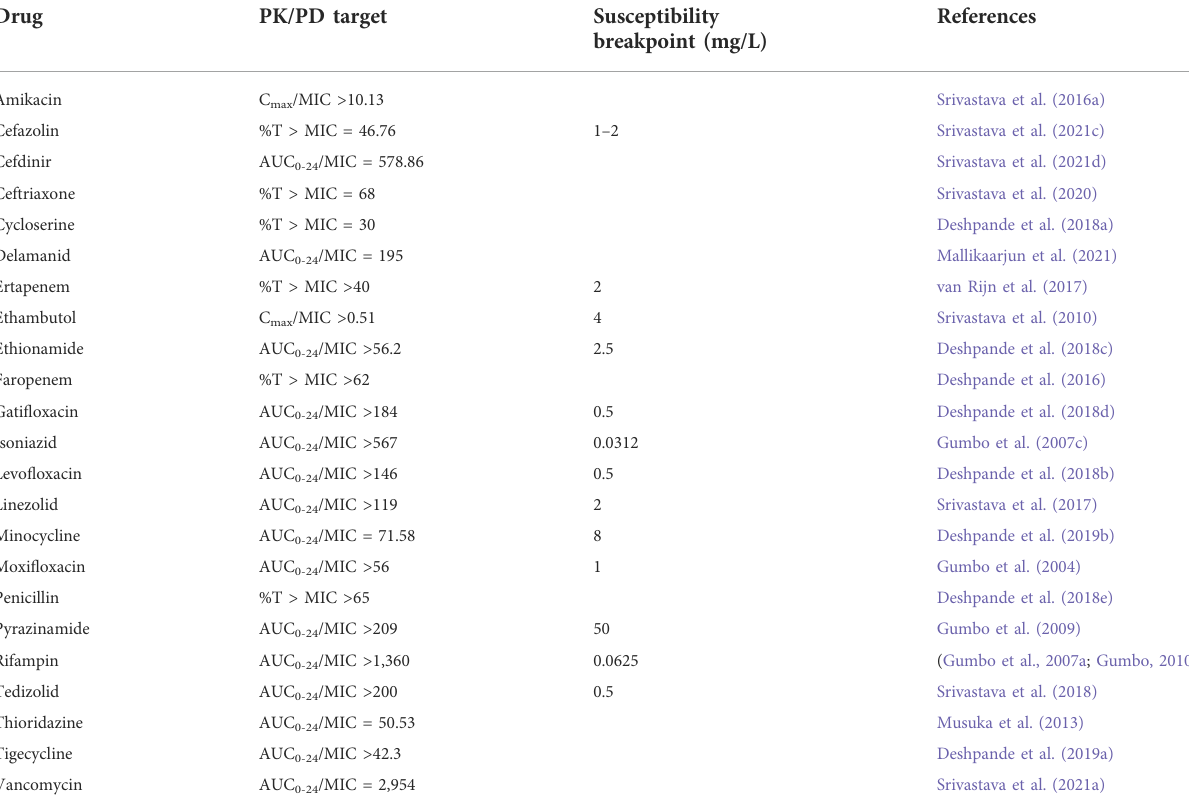
TABLE 1 HFS-TB derived drug exposure target and susceptibility breakpoint MIC of drugs with antimycobacterial